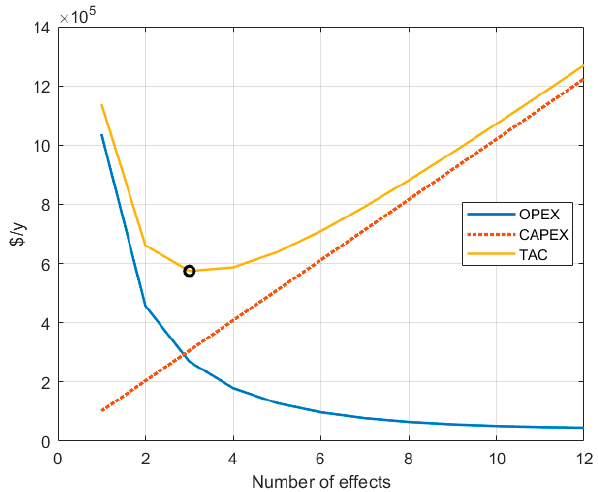
Figure 3. Multiple-effect TAC under nominal operating